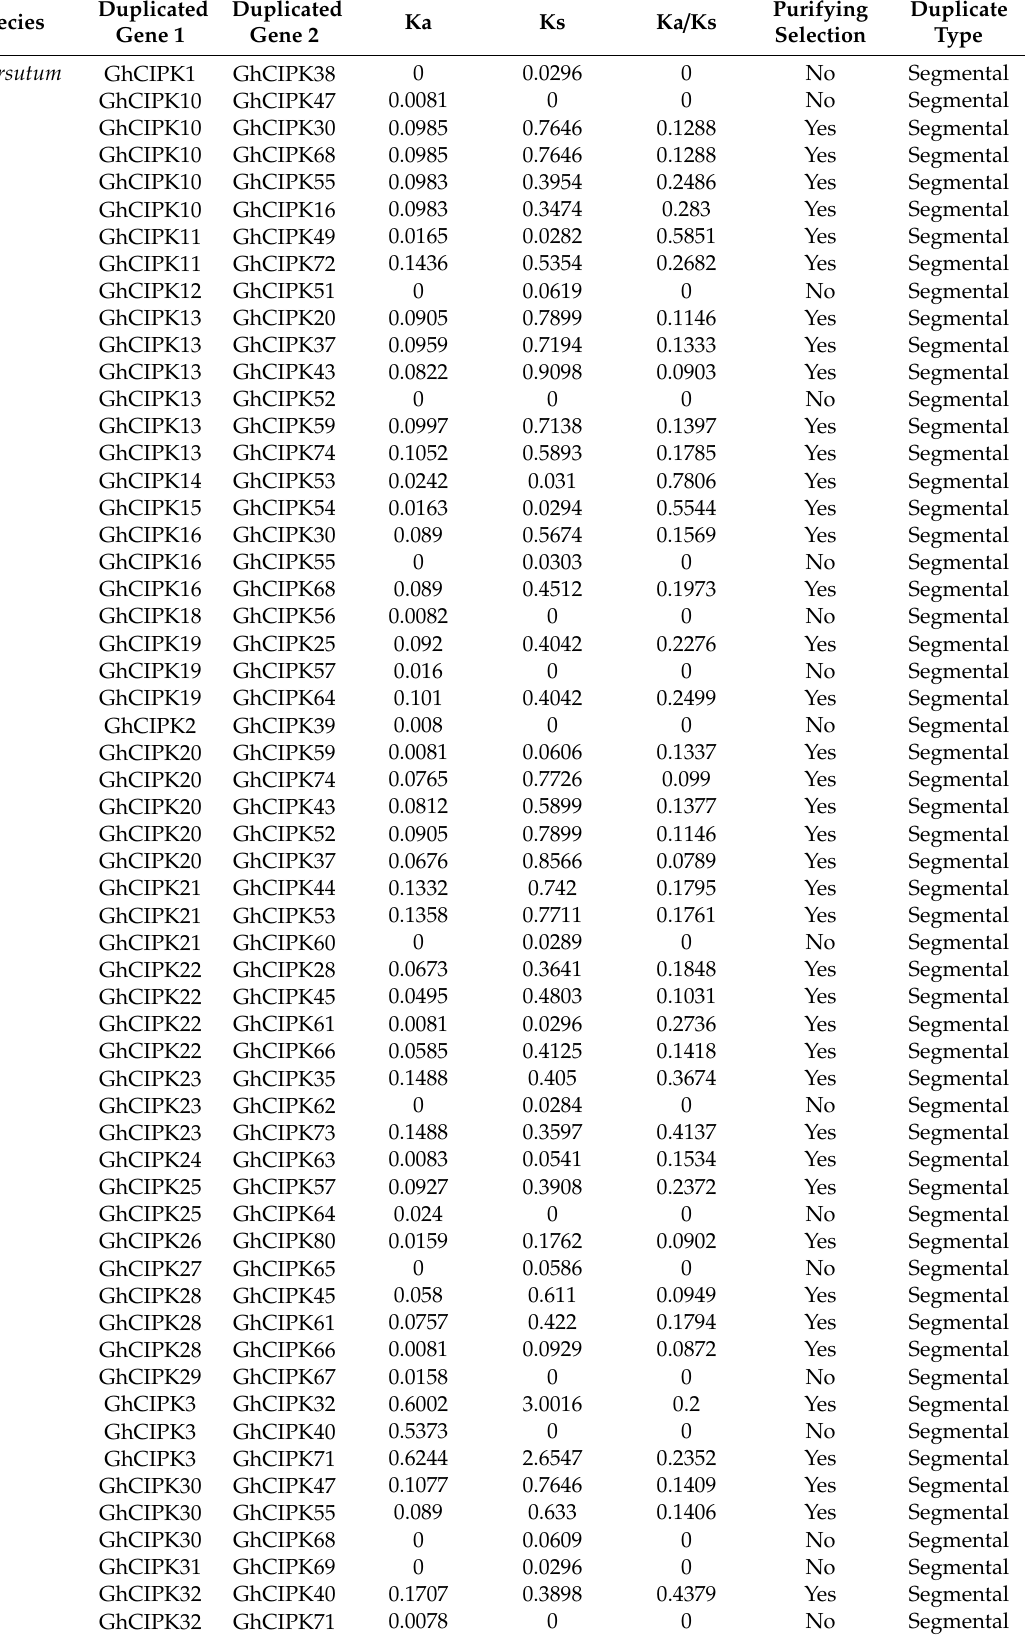
Table 1. Ka / Ks analysis for the duplicated CIPK gene pairs in G. hirsutum and G. barbadense .